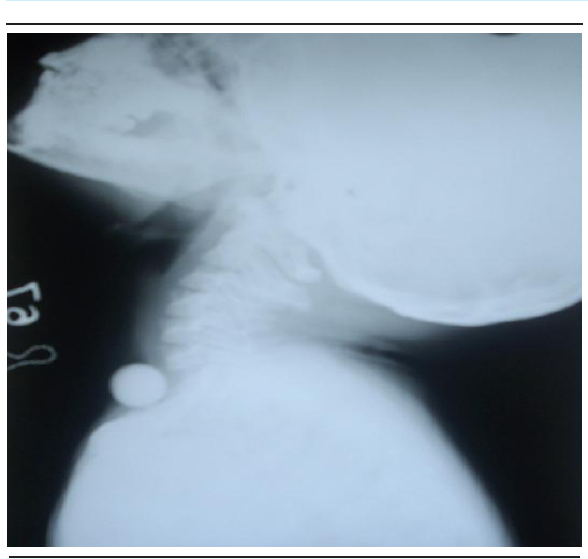
figure 1. X-ray soft tissue neck showing radio opaque foreign body at c6-7 level